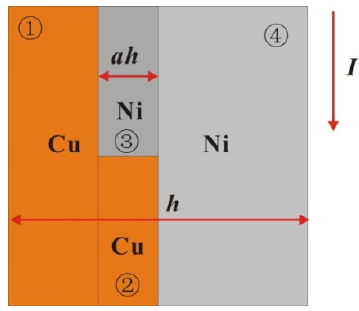
Figure 9. Single-layer mixing model of multilayer foil (horizontal direction is its thickness direction). Micromachines 2020 , 11 , x